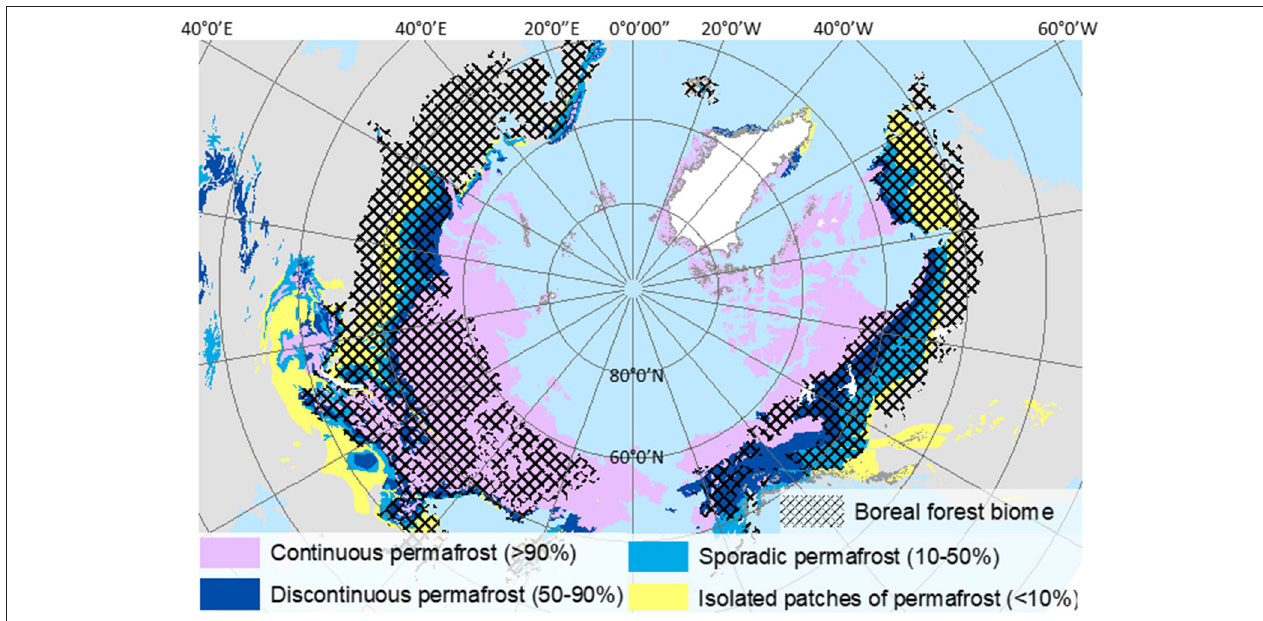
FIGURE 1 | Permafrost coverage in the northern hemisphere (from Brown et al., 2002). Stipled pattern overlay represents the boreal forest biome